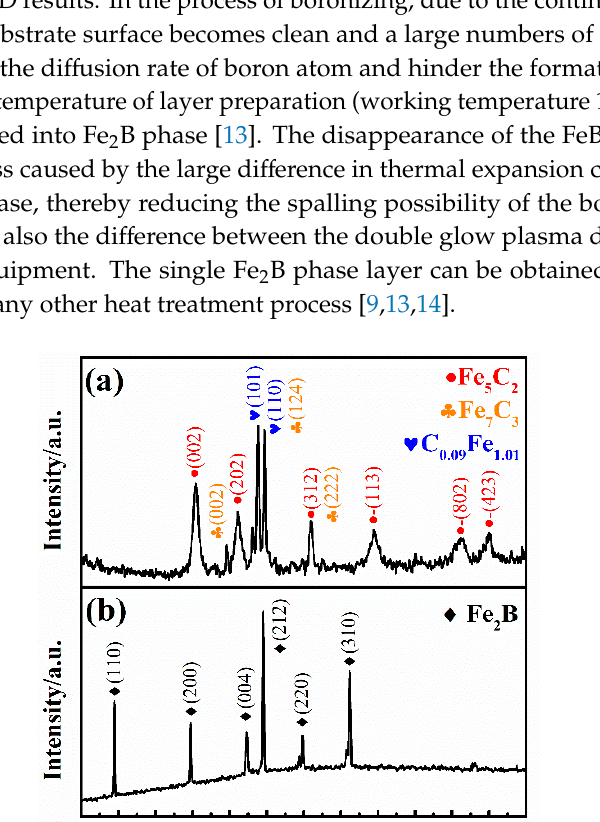
Figure 2. SEM images of the borocarburized layer ( a ) C deposition, ( b ) B deposition, ( c ) cross-section image ( d ) EDS result.